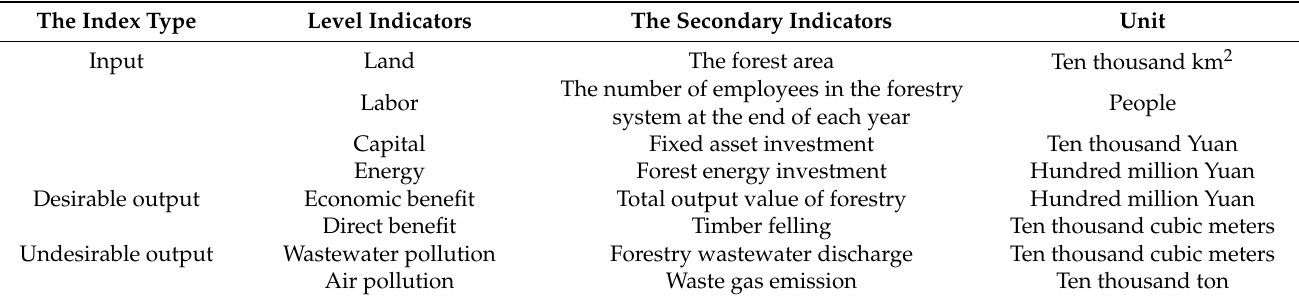
Table 1. Input and output indicators for measuring forestry ecological